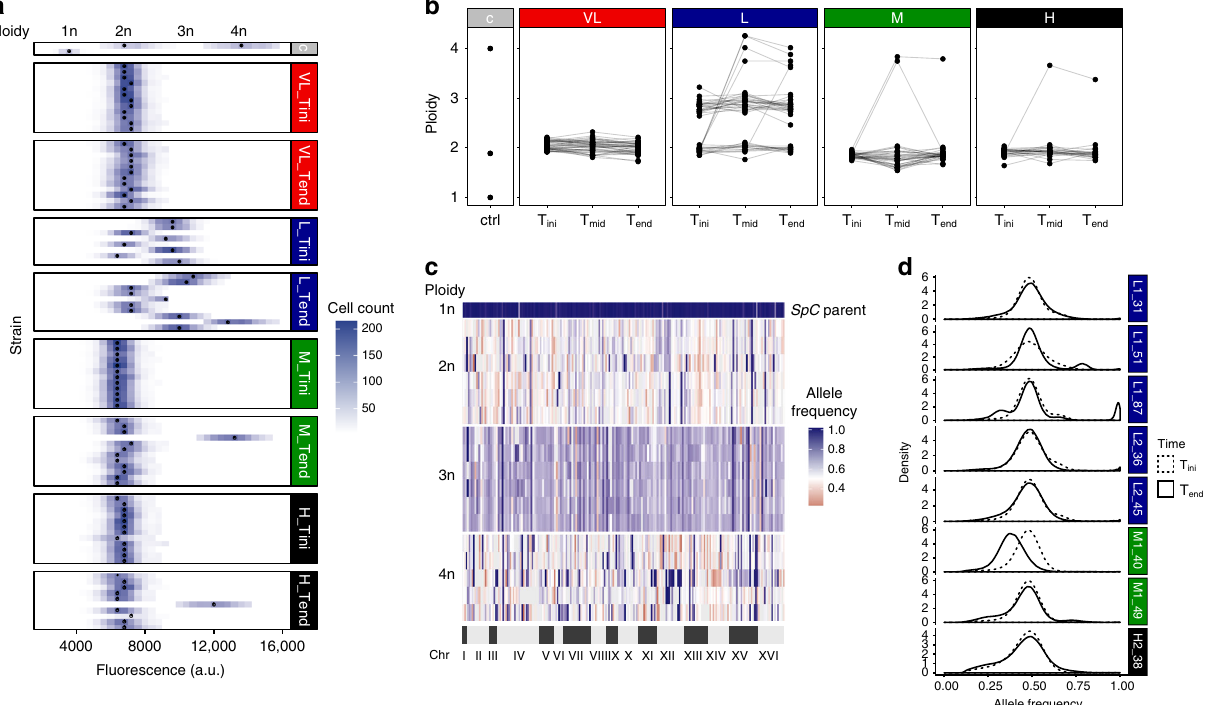
Fig. 3 Ploidy varies among hybrids and evolves through time. a Ploidy of a subset of 12 hybrid lines after hybridization (T ini ) and after ~770 (T end ) of mitotic generations. The c gray panel corresponds to controls and black circles indicate the highest cell count whose variability suggest that aneuploidy is prevalent in hybrid lines. b Ploidy at the three tested timepoints (T ini , T mid , and T end ). Connected dots represent independent lines (24). The c gray panel corresponds to controls. c Frequency of 171 markers corresponding to the SpC parent alleles across the genome of a subset (six diploids, six triploids, and all the fi ve tetraploids) of L div lines show around 50% of SpC alleles in the diploid and tetraploid strains and 66% in triploid strains. d Allele frequencies estimated by whole-genome sequencing across the 16 chromosomes. Because diploid hybrids have one copy of each genome, allele frequencies are centered around 50% at T ini . This frequency is preserved in most tetraploids, showing the all chromosomes were doubled at T end . Loss of heterozygosity is detectable as alternative peaks for instance at 100% (e.g., L1_87) in tetraploids when it involves the loss of one of the two parental alleles. Aneuploidies are also detectable as alternative peaks at 80% (e.g., L1_51) or 30% (e.g. L1_87). M1_40 shows one peak at about 30% suggesting that the sequenced clone of that line is a triploid. The allele frequencies correspond to the hybrid parent 2 alleles ( SpC for L lines, SpA for M lines, and S. cerevisiae for the H